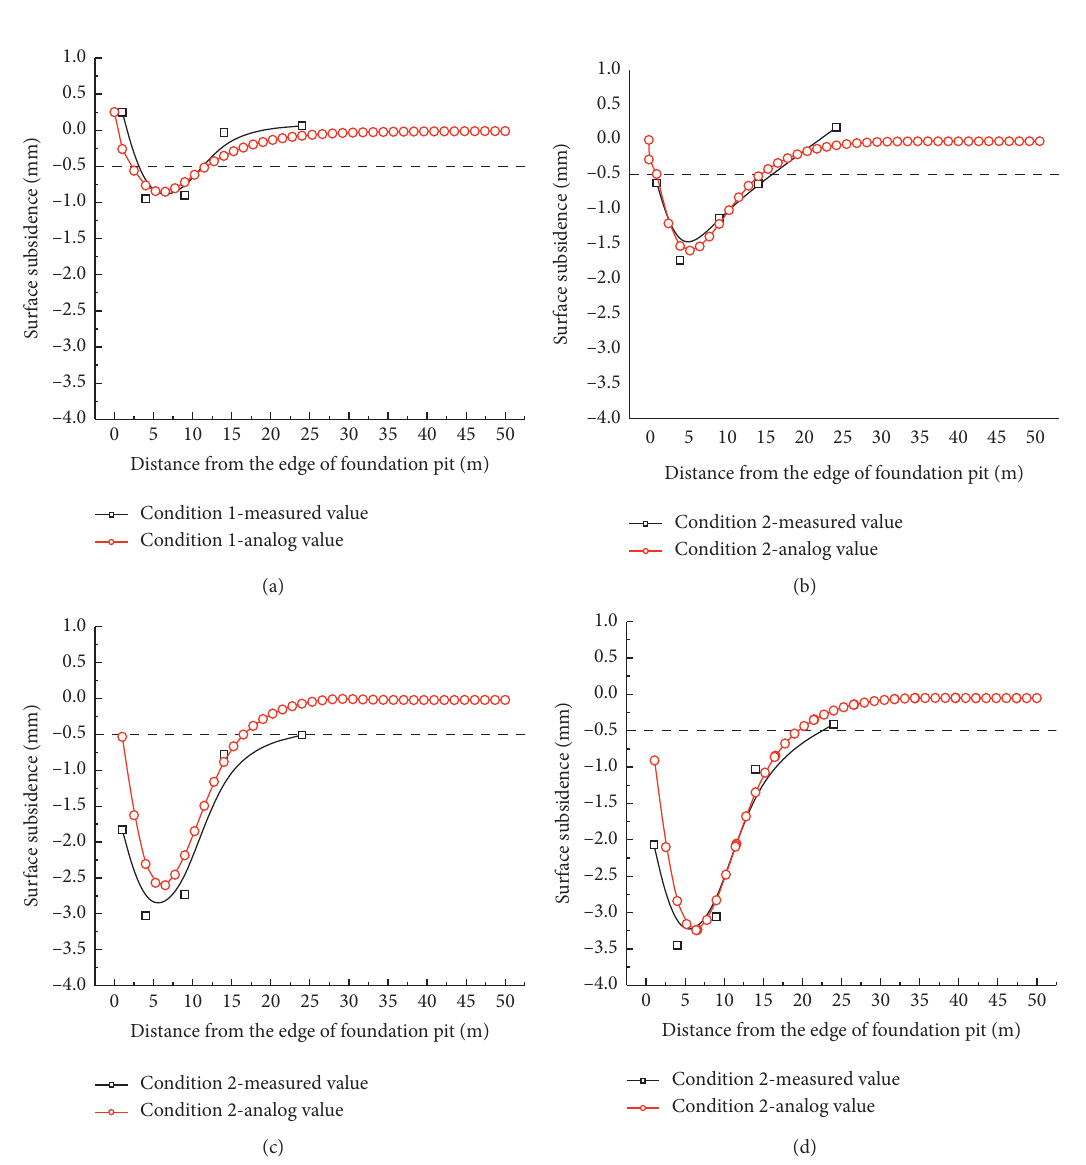
Figure 2: Ground settlement outside the pit under various working conditions. (a) Condition 1. (b) Condition 2. (c) Condition 3. (d) Condition